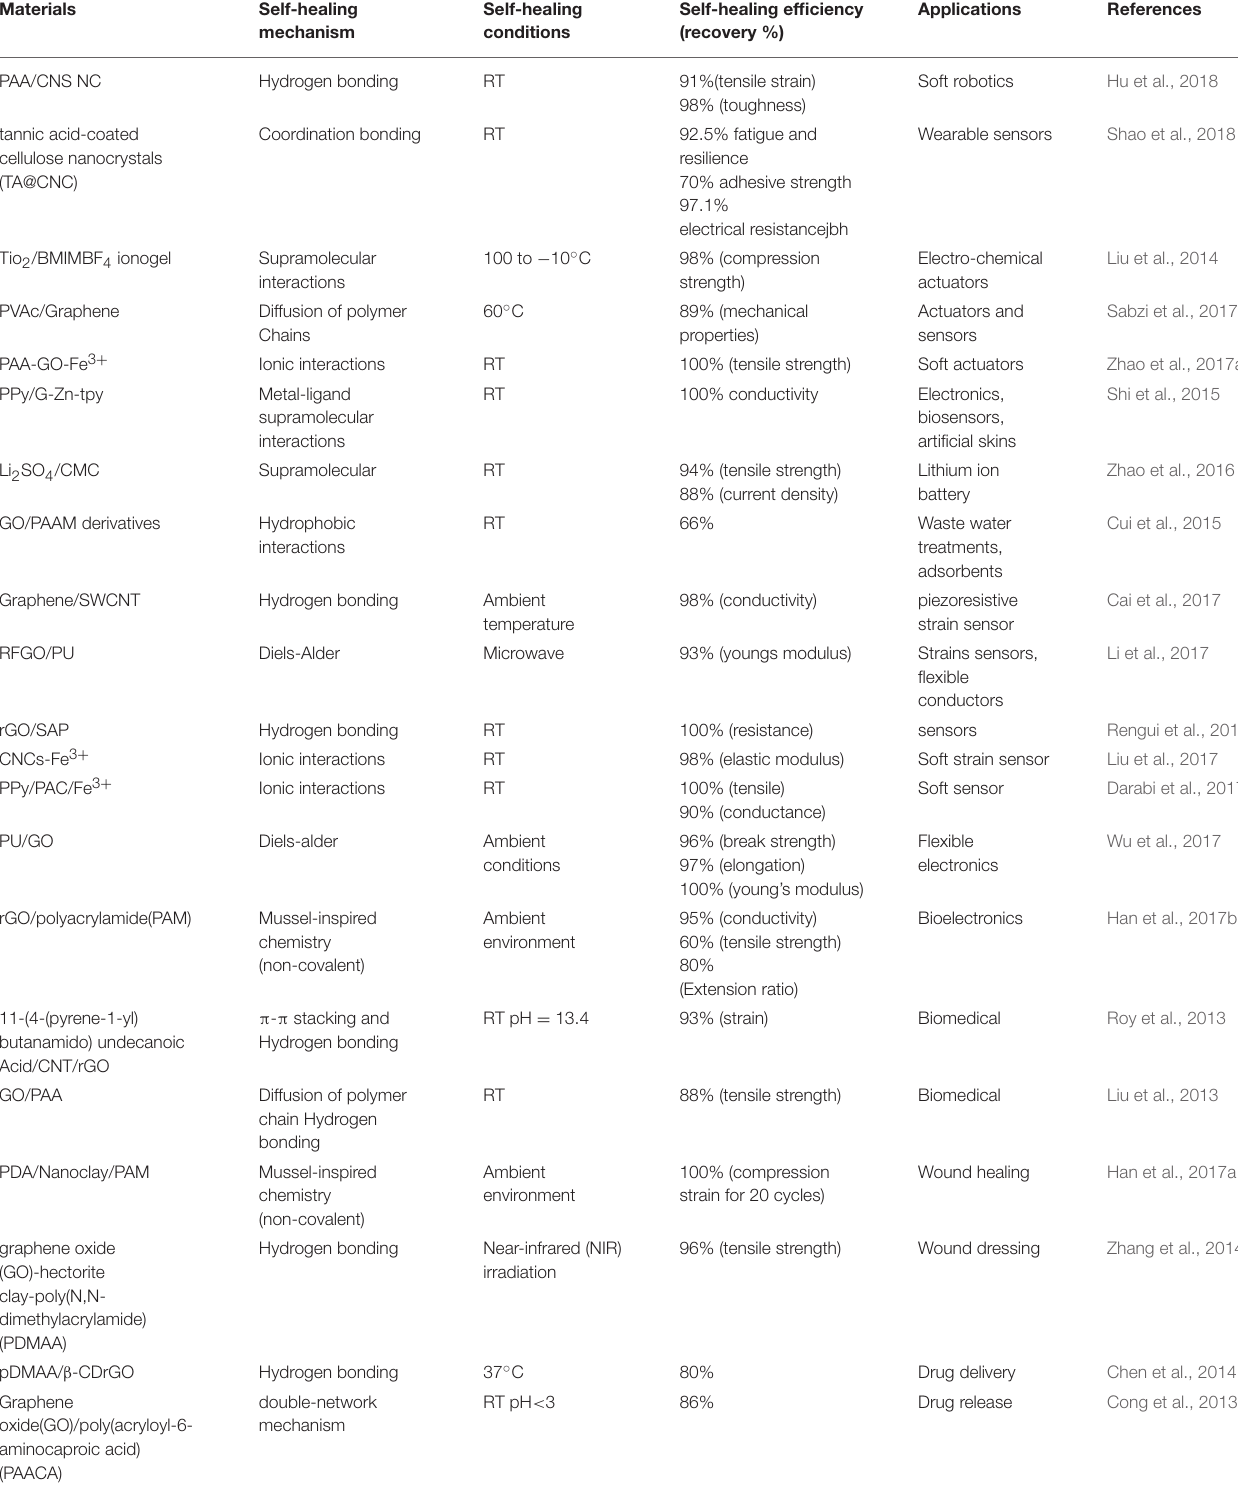
TABLE 5 | Demonstrated applications for soft self-healing nanocomposites and associated healing